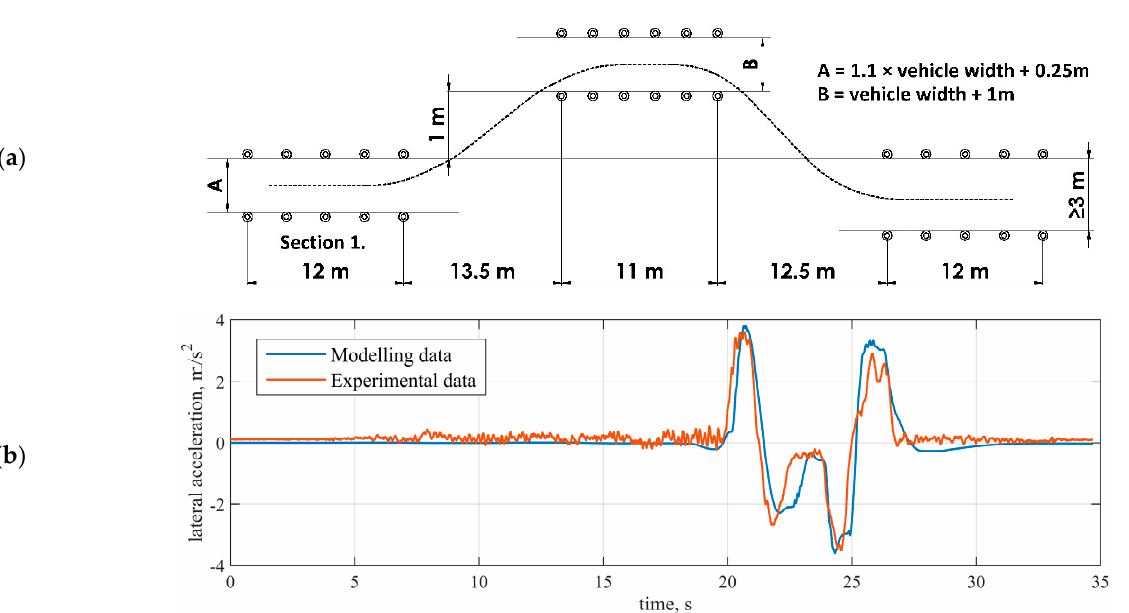
Figure 4. Obstacle avoidance test (ISO 3888-2:2011): ( a ) manoeuvre scheme; ( b ) sprung mass lateral accelerations during the